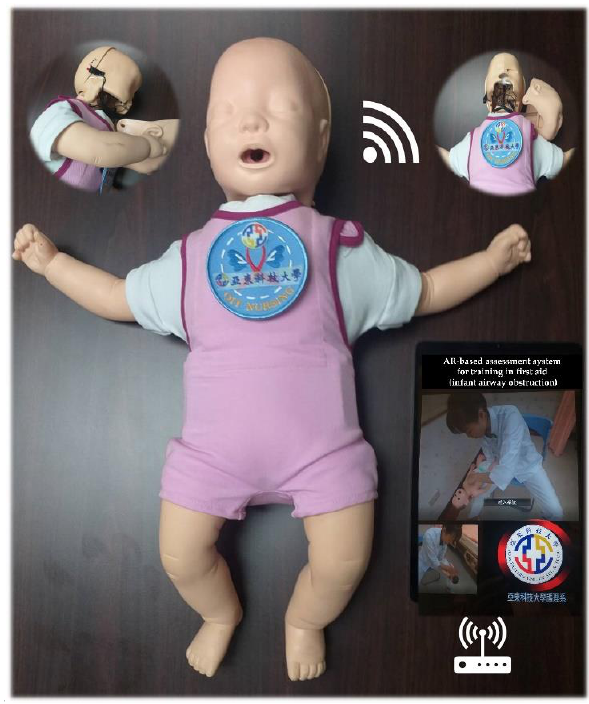
Figure 4. Wireless transmission system.